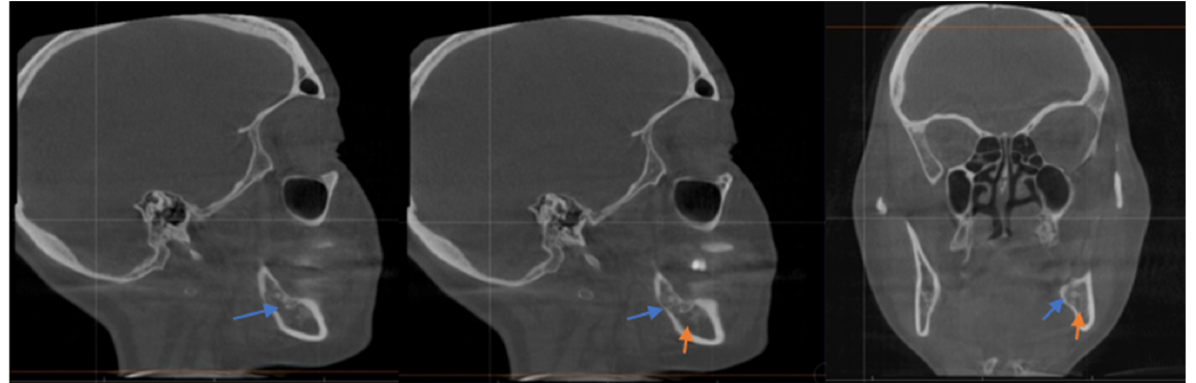
Figure 2. Sagittal CT scan: Note the proximity of the mineralized xenograft in tooth #17 (Blue Arrow) following surgical removal and bone graft procedure to inferior alveolar nerve canal (Orange Arrow).